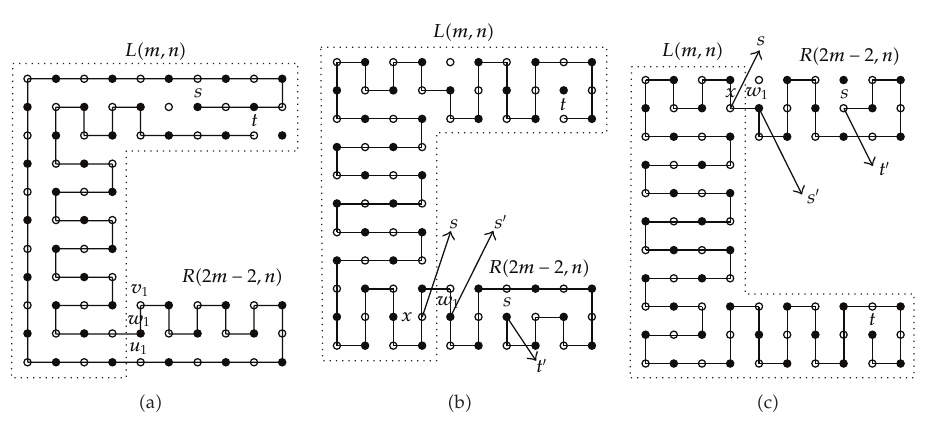
Figure 8: C -alphabet grid graphs in which there is no Hamiltonian path between s and t .